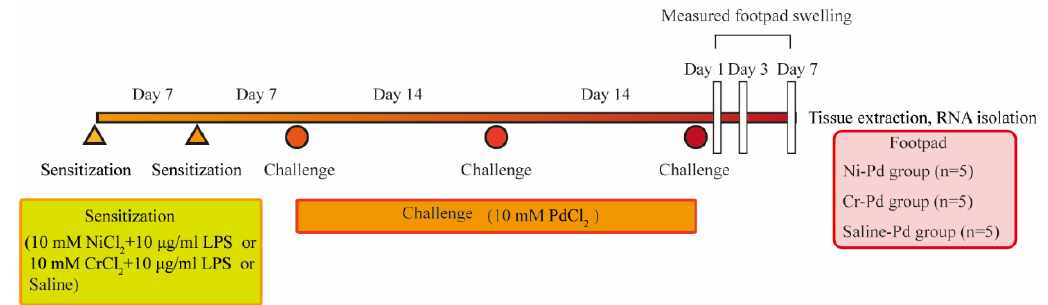
Figure 7. Schedule of the sensitization and challenge of the metal allergy cross-reactive mouse model. Sensitization using NiCl 2 + lipopolysaccharide (LPS) or CrCl 2 + LPS or saline were injected twice (at an interval of 7 days) intradermally (i.d.) into the left and right groin of mice. At 7 days after sensitization, mice were challenged for the first time. PdCl 2 was injected into the left and right footpad by i.d. injection to challenge and elicit an immune reaction. Challenge was repeated three times at an interval of 14 days.